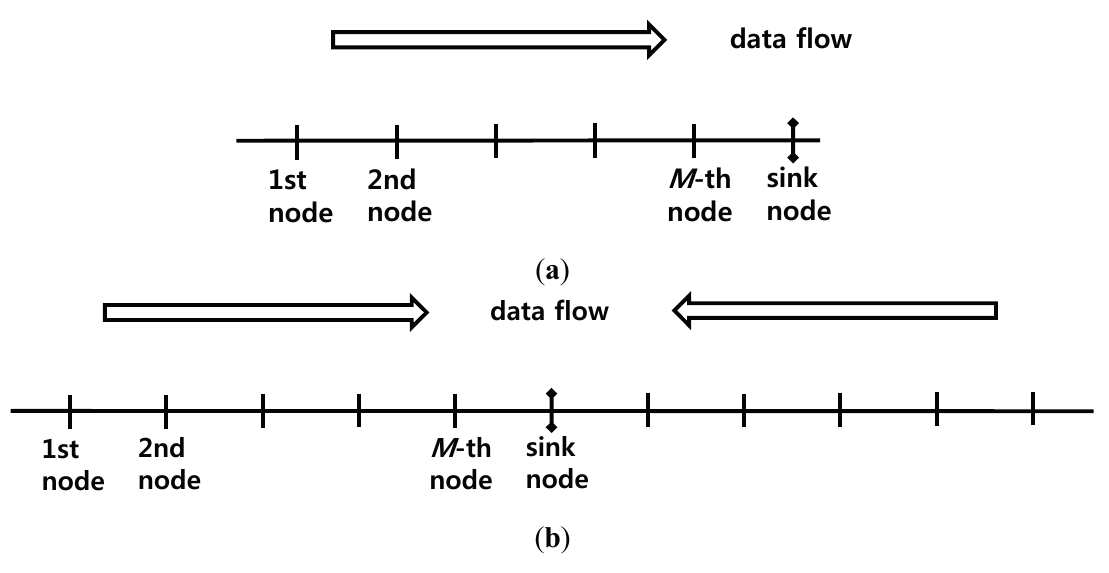
Figure 3. One-dimensional linear data flow. ( a ) The sink node is located at the end; ( b ) The sink node is located at the